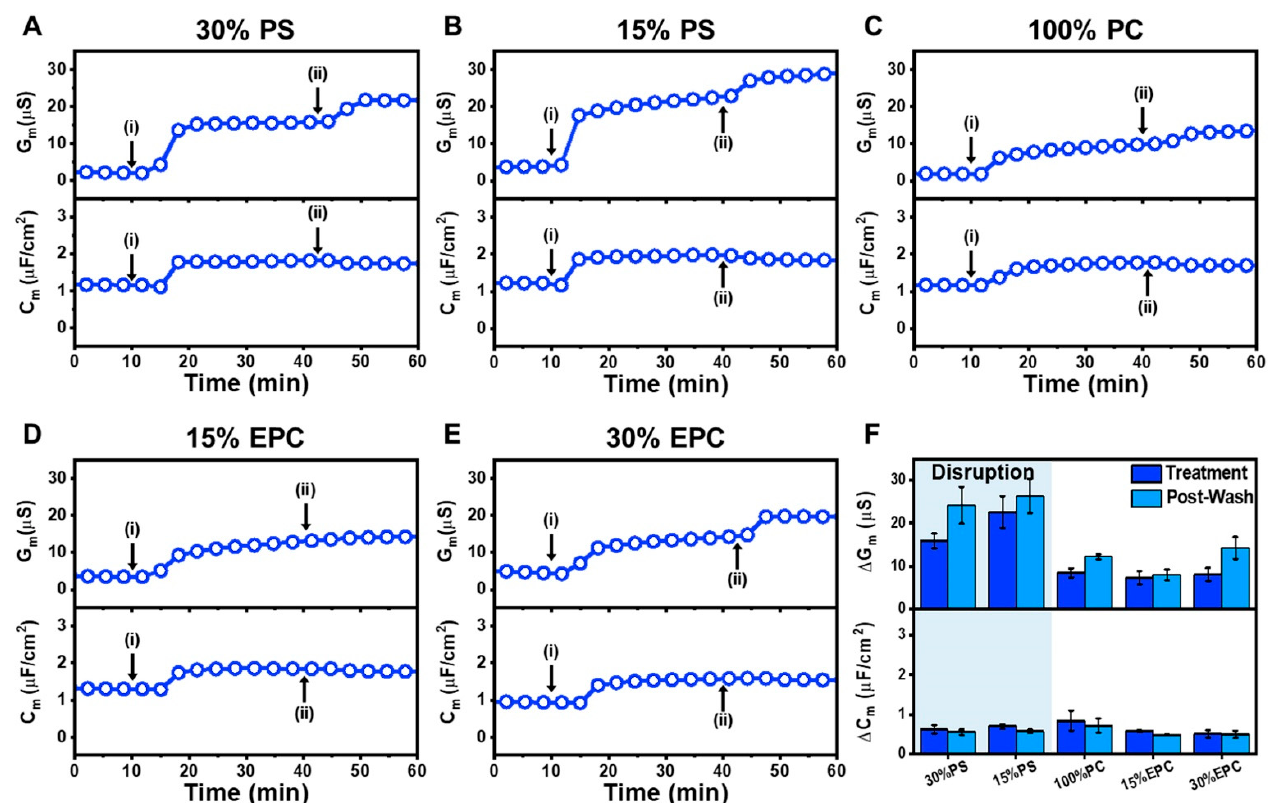
Figure 6. EIS tracking of LTX-315 peptide interactions with tethered lipid bilayers depending on membrane surface charge: ( A ) time-dependent changes in conductance (G m ) and capacitance (C m ) signals upon LTX-315 peptide addition to a 70/30 DOPC/DOPS tBLM platform. LTX-315 peptide was added to the tBLM platform starting at t = 10 min (arrow i), followed by a buffer washing step from t = 30 min onward (arrow ii); corresponding EIS data for ( B ) 85/15 DOPC/DOPS, ( C ) 100 DOPC, ( D ) 85/15 DOPC/DOEPC, and ( E ) 70/30 DOPC/DOEPC tBLM platform; and ( F ) summary of G m and C m shifts upon LTX-315 peptide addition (treatment) and after buffer washing (post-wash) for tBLMs with different membrane surface charges. The data are reported as the mean ± standard de- viation from n =3 measurements.